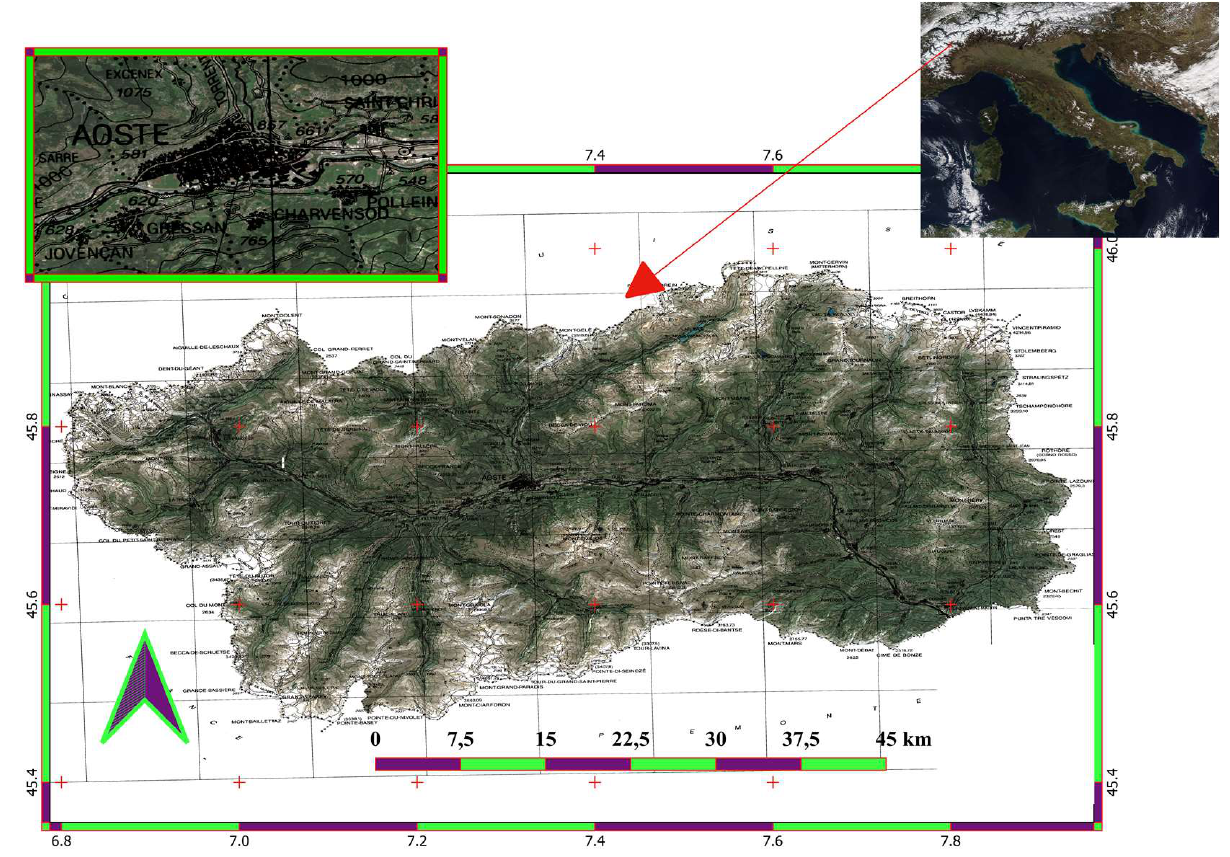
Figure 1. Study Area corresponding to the boundaries of the Aosta Valley Autonomous Region (NW Italy) (EPSG:23032).